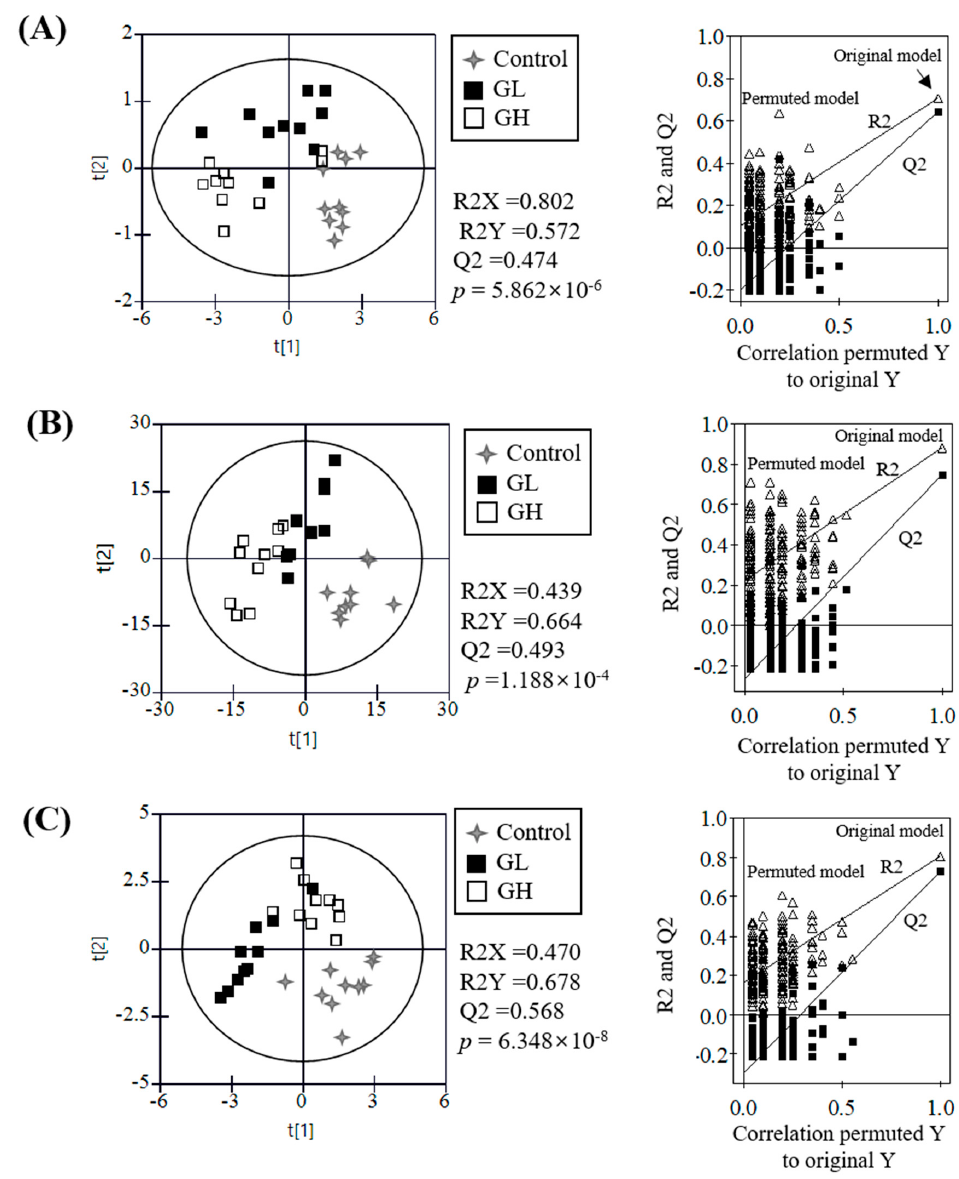
Figure 1. Partial least-squares discriminant analysis (PLS-DA) score plots of plasma metabolites ( A ), kidney metabolites ( B ), and plasma and urine steroid hormones ( C ). The qualification of the PLS-DA models was evaluated by R2X, R2Y, Q2, and p -values and validated by cross validation with a permutation test ( n = 200). R2X and R2Y showed the fitting quality of the models and Q2 showed their prediction quality. Cross validation was evaluated by intercepts of R2X and R2Y and their final values.